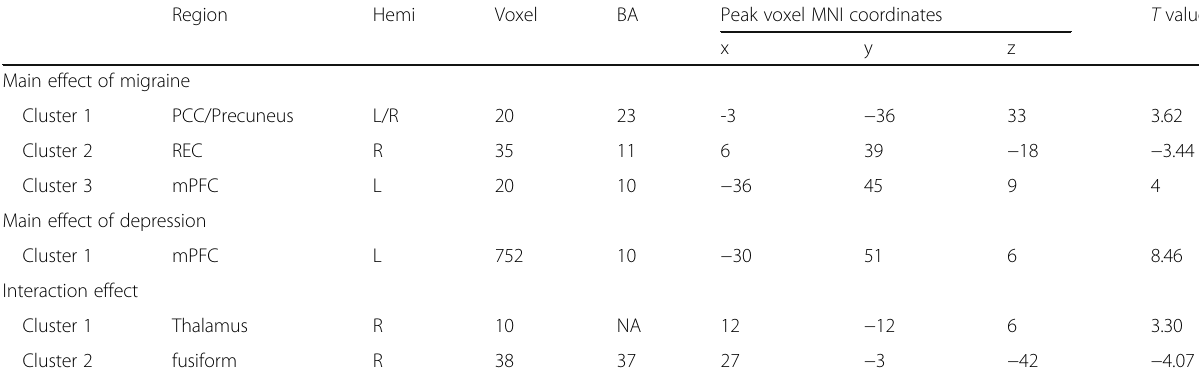
Table 2 Brain regions showing significant main and interaction effects among four groups Region